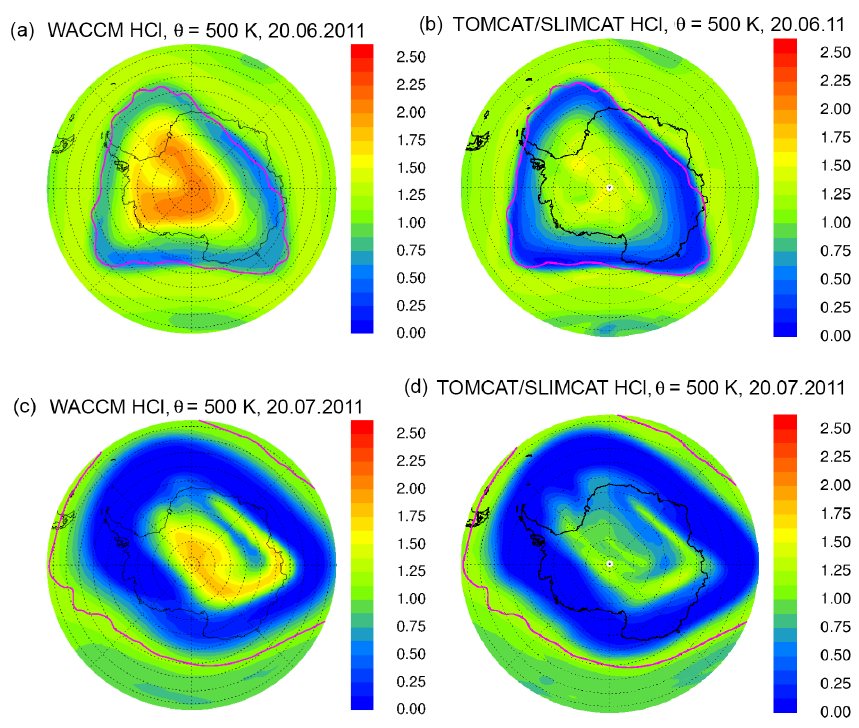
Figure 5. Simulated HCl from SD-WACCM (a, c) and TOMCAT/SLIMCAT (b, d) on the 500K potential temperature surface for 20 June (a, b) and 20 July 2011 (c, d) displayed as in Fig.